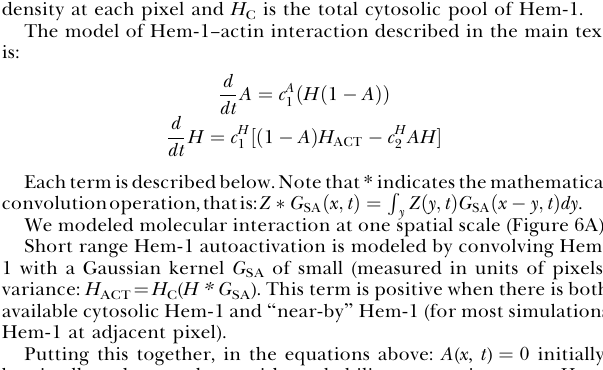
Figure S1. Parameter Scans of Wave